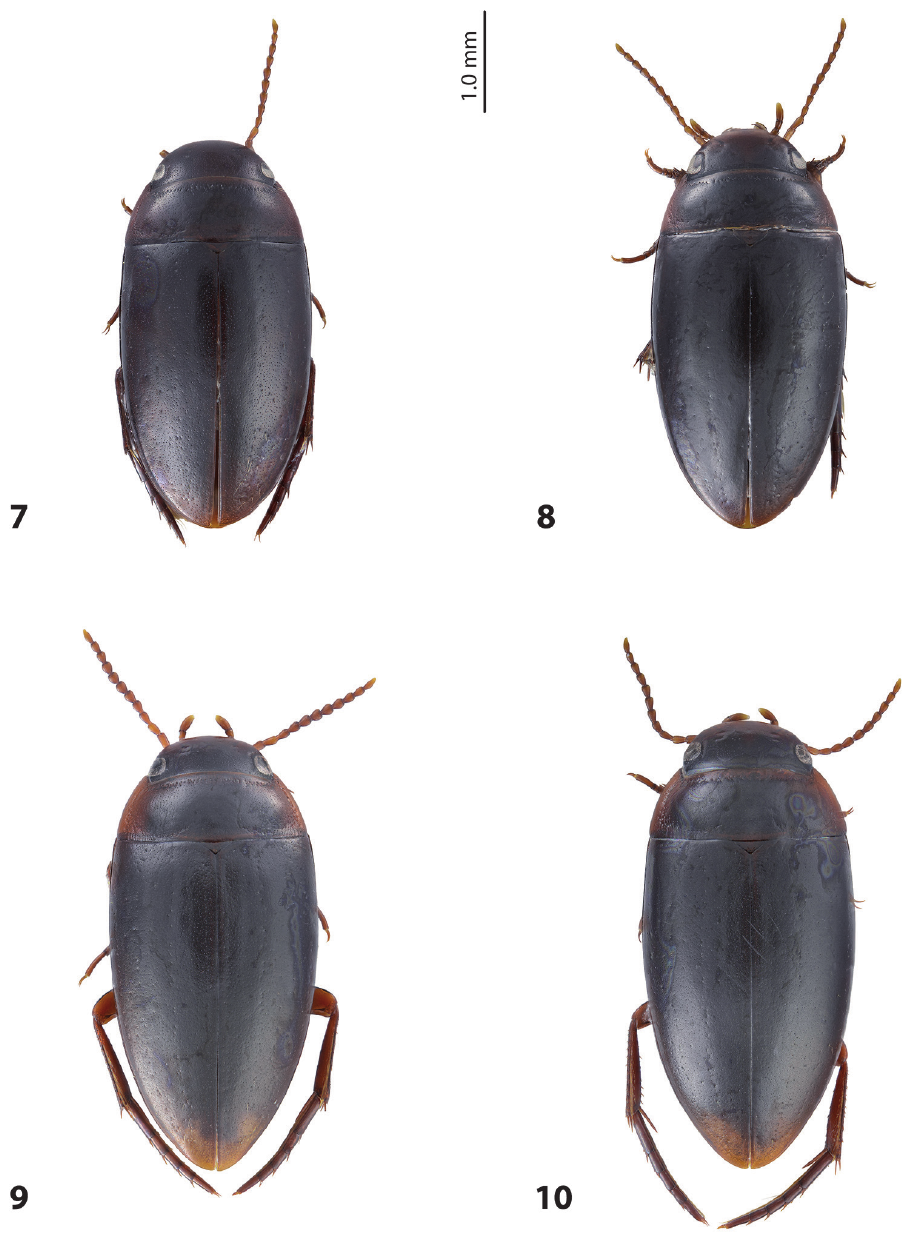
10 E. pulukensis sp.